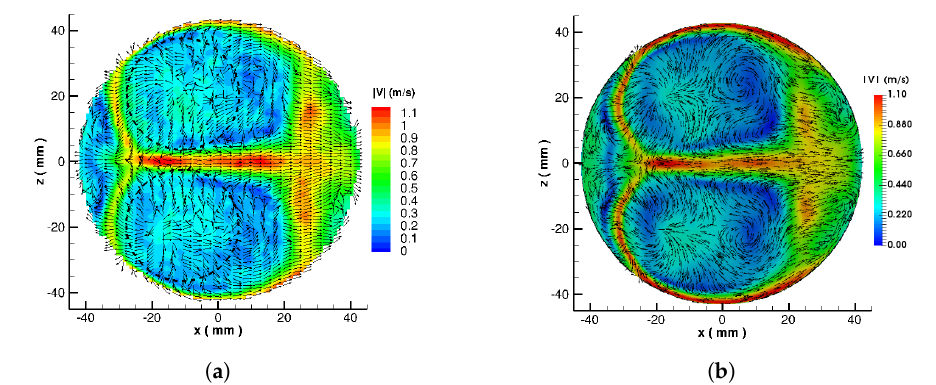
Figure 8. Comparison of velocity contour in swirl plane below the intake ports ( Y = − 10 mm).